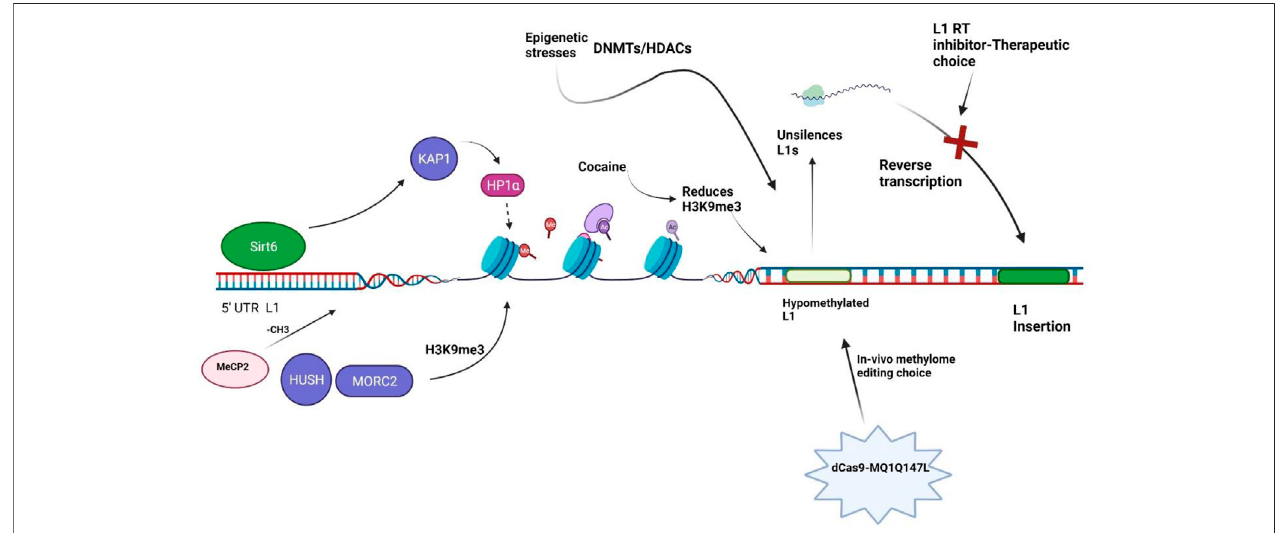
FIGURE 2 | Illustration of chromatin remodelers. Sirt6: Sirtuin 6, KAP1: Krüppel-associated box 1/KRAB-associated protein 1, HP1 α : Heterochromatin Protein 1 α , H3K9me3: methylation of lysine 9 of histone H3, HUSH: human silencing hub-complex, MORC2: Microrchidia CW-type Zinc Finger 2, DNMTs: DNA methyltransferases, HDACs: Histone Deacetylases, MeCP2 : Methyl-CpG-binding protein 2, L1 RT : L1 reverse transcriptase.